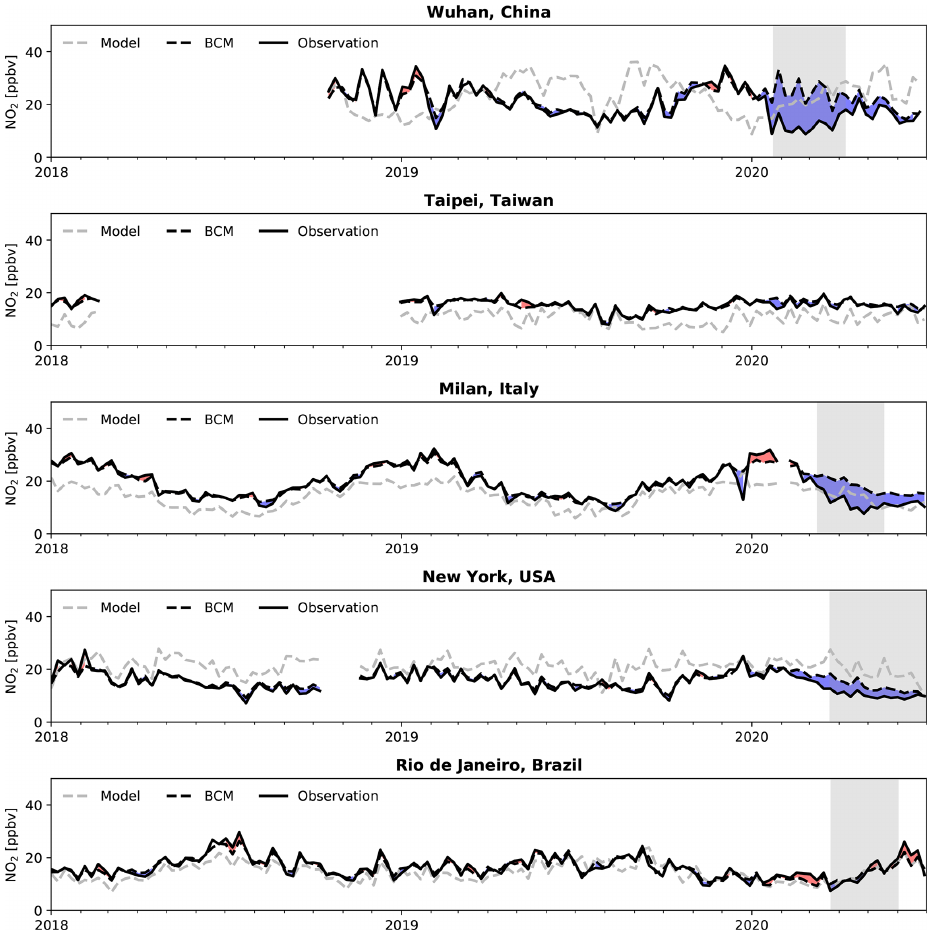
Figure 4. Comparison of NO 2 surface concentrations (ppbv = nmolmol − 1 ) for Wuhan, Taipei, Milan, New York, and Rio de Janeiro for January 2018 through June 2020. Observed values are shown in solid black, the original GEOS-CF model simulation is shown in dashed grey, and the BCM predictions are in dashed black. The area between observations and BCM predictions is shaded blue (red) if observations are lower (higher) than BCM predictions. Grey areas represent the period of lockdown. Shown are the 7d average mean values for the 9, 18, 19, 14, and 2 observational sites in Wuhan, Taipei, Milan, New York, and Rio de Janeiro, respectively. Observations for China are only available starting in mid-September